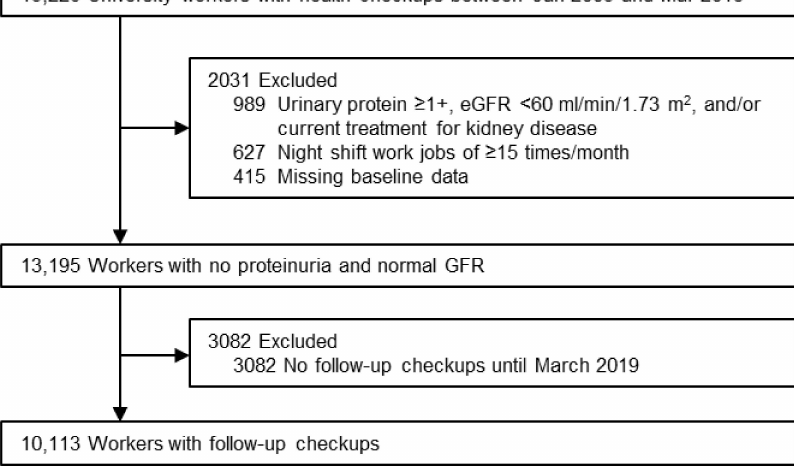
Figure 1. Flow diagram of the entry of